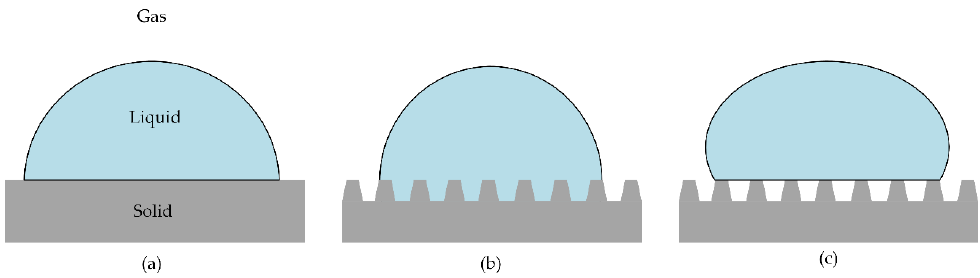
Figure 6. Schematic diagrams of di ff erent wetting status: ( a ) ideal status. ( b ) Wenzel status. ( c ) Cassie–Baxter